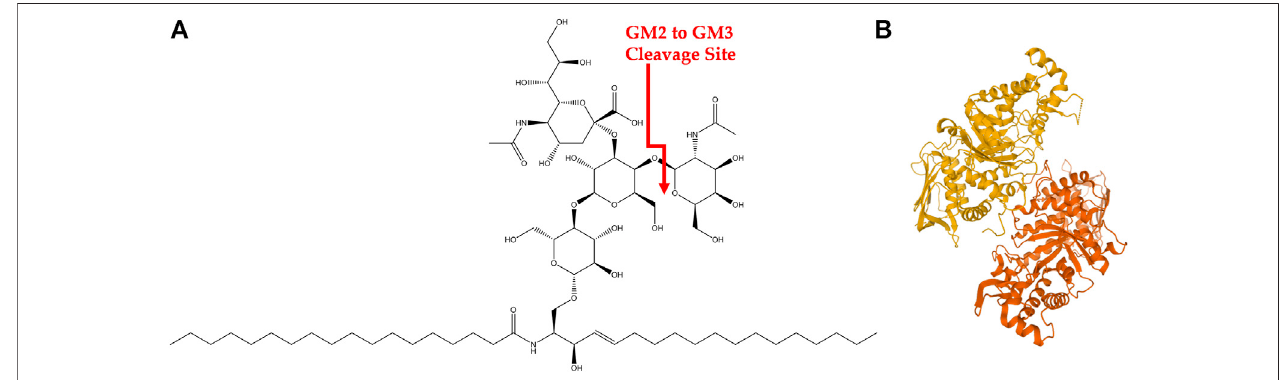
FIGURE1| GM2GangliosideandHexA (A) StructureofGM2ganglioside.CleavagesiteofGM2intoGM3 via HexAisshowninred. (B) HexAisoenzymewithalpha subunit (orange) and beta subunit (yellow).